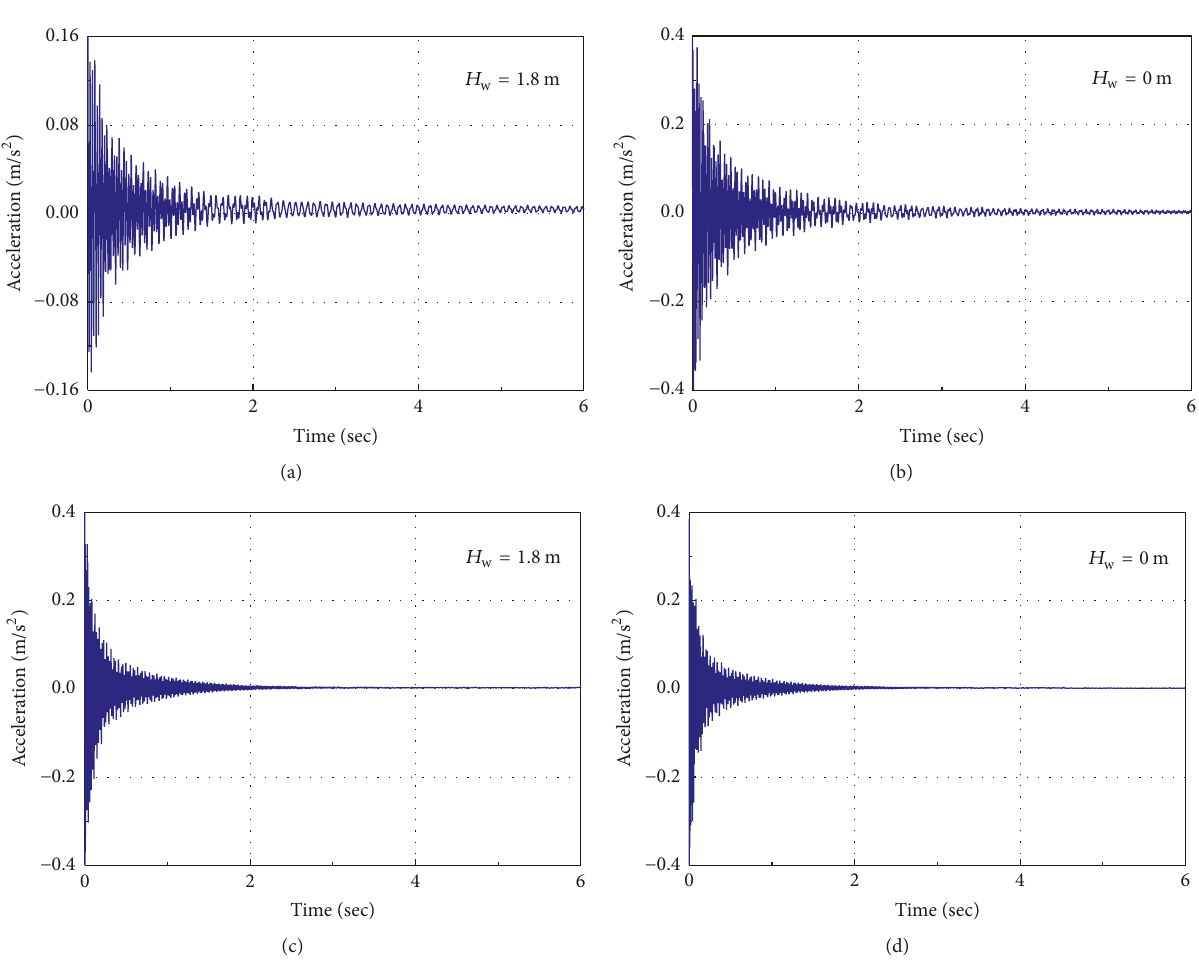
Figure 6: Acceleration signals acquired by the top accelerometers for the specimen without tip mass, corresponding to (a) 𝐻 w = 1.8 m along 𝑥 -axis; (b) 𝐻 = 0 m along 𝑥 -axis; (c) 𝐻 = 1.8 m along 𝑦 -axis; (d) 𝐻 = 0 m along 𝑦 w w w